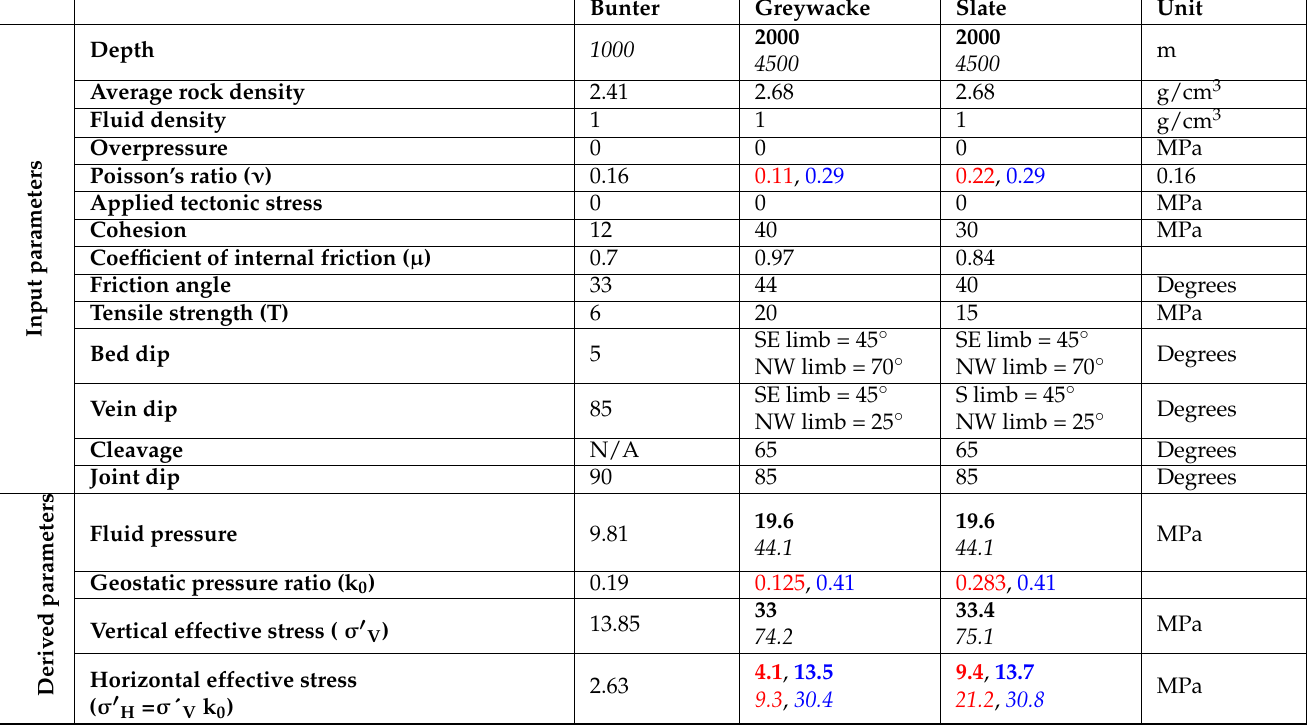
Table 3. Parameters used to model the base case scenarios for the Bunter Sandstone and the Devonian and Carboniferous greywackes and slates, with stresses and fluid pressures rounded to one decimal place. Values that depend on different geostatic stress ratios (k 0 ) are shown in different colours (red for lower k 0 values in range, blue for upper k 0 values). Values specific to a modelled depth of 2 km are shown in bold, and values specific to a modelled depth of 4.5 km are shown in italics. Representative structures are shown for the dips of structures in both the SE- and NW-dipping limbs of folds in the greywackes and slates. Effective stresses are calculated assuming a Biot coefficient of 1. Bunter Greywacke Slate